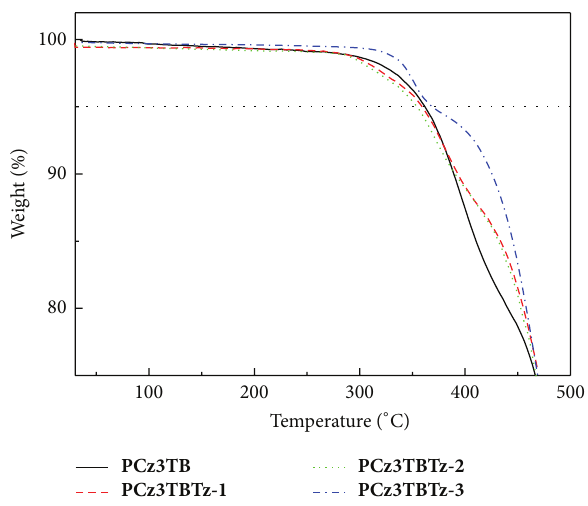
Figure 1: TGA thermograms of the copolymers.